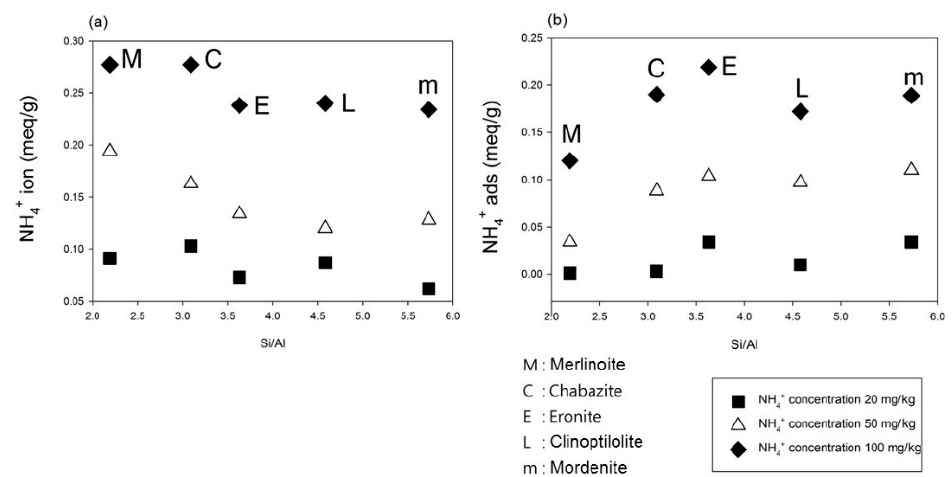
Figure 3. Relationships of ( a ) ion exchange and ( b ) adsorption capacities with the Si/Al ratios of zeolites for different ammonium solutions.